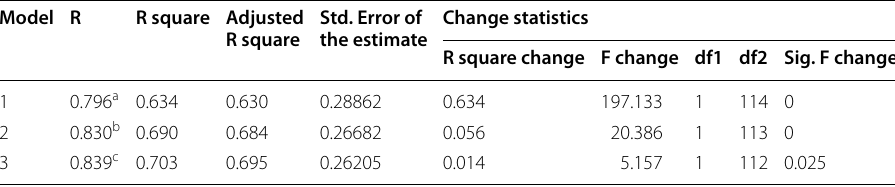
a Predictors: (Constant), cognitive b Predictors: (Constant), cognitive, social c Predictors: (Constant), cognitive, social, teaching d Dependent Variable: learning outcomes